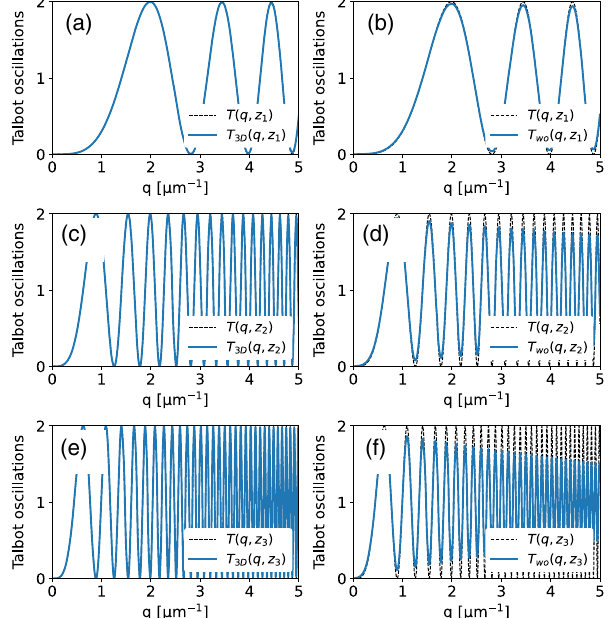
FIG. 5. Effect of 3D scattering [(a), (c), and (e)] and walk-off [(b), (d), and (f)] on Talbot oscillations for three progressively increasing sample-detector distances z 1 ¼ 5 cm [(a) and (b)], z 25 cm [(c) and (d)] and z 50 cm [(e) and (f)] and for the 2 ¼ 3 ¼ actual experimental parameters described in Sec. III. FIG. 6. Simulated horizontal profiles of 2D power spectra for three different distances z 1 ¼ 10 cm, z 2 ¼ 30 cm and z 3 ¼ 50 cm as a function of Fourier wave vectors (a) and transverse displacements (b). Upon the spatial scaling, Talbot maxima and minima clearly fit onto the two unique master curves of the upper and lower envelope u ð Δ x Þ and w ð Δ x Þ , respectively, as described by Eq.